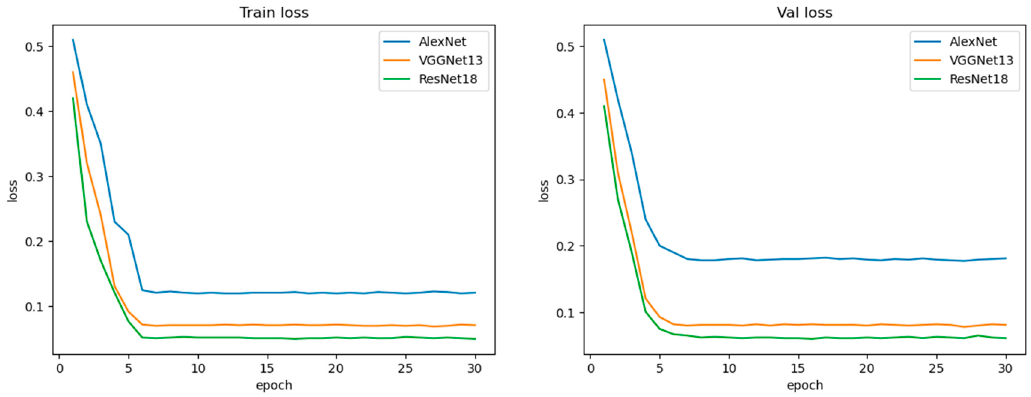
Figure 7. Loss Figure 7. Loss curve.